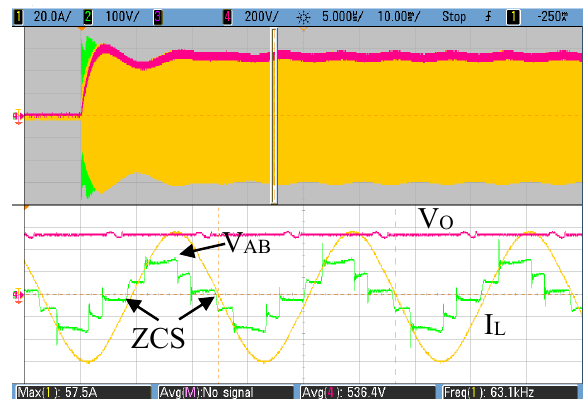
Figure 14. Evolution of voltage V AB [100 V/div] output voltage V O [500 V/div] and current I L [100 A/div] in the traditional LCC converter with a load R O = 88.5 Ω , P O = 3.8 kW.